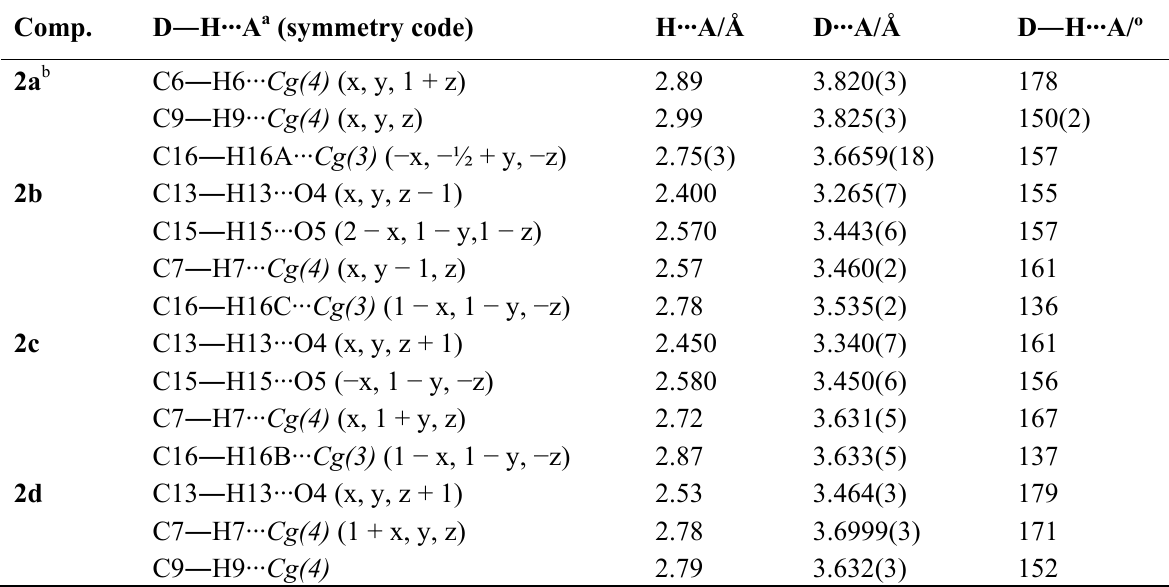
Table 4. Geometric parameters associated with D ― H···A (A = O, π ) interactions for compounds 2a–d .